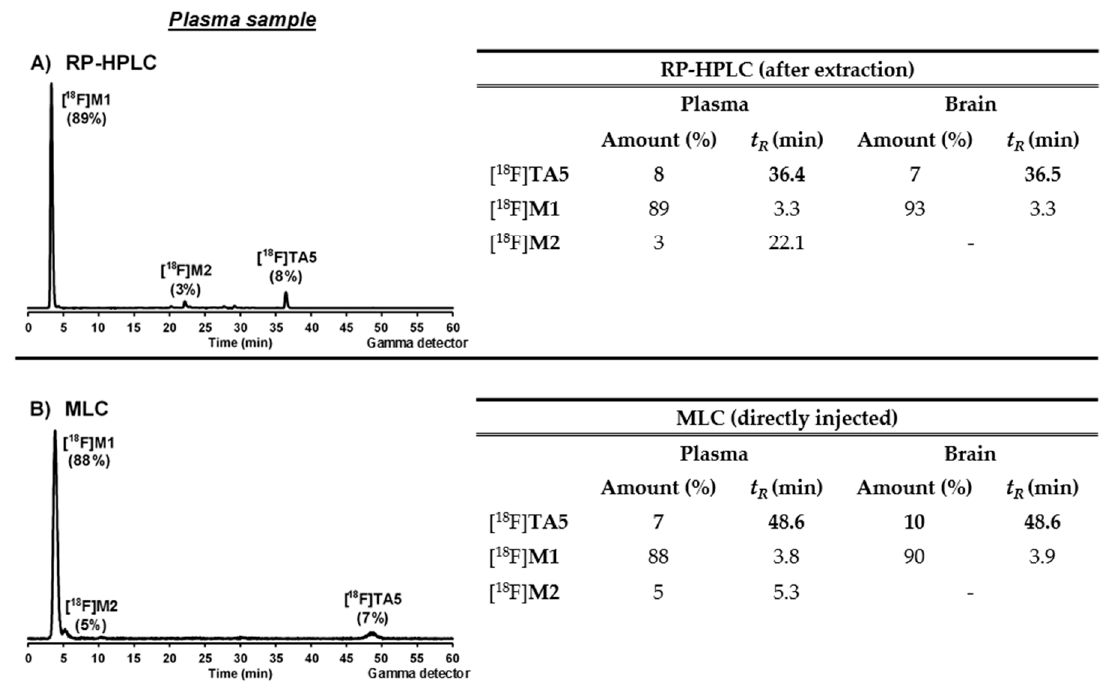
Figure 3. Representative in vivo metabolism study of mouse plasma and brain samples at 30 min p.i. of [ 18 F] TA5 (~70 MBq): ( A ) RP-HPLC chromatogram of extracted plasma sample (column: Reprosil-Pur C18-AQ, 250 x 4.6 mm, particle size: 5 µ m; gradient: 10–90–10% MeCN/20 mM NH 4 OAc aq. ; flow: 1 mL/min); ( B ) MLC chromatogram of directly injected plasma sample (column: Reprosil-Pur C18-AQ, 250 x 4.6 mm, particle size: 10 µ m; gradient: 3-30-3% 1-PrOH/100 mM SDS aq. , 10 mM Na 2 HPO 4aq. ; flow: 1 mL/min); Tables: percentages and retention times of intact [ 18 F] TA5 and radiometabolites from